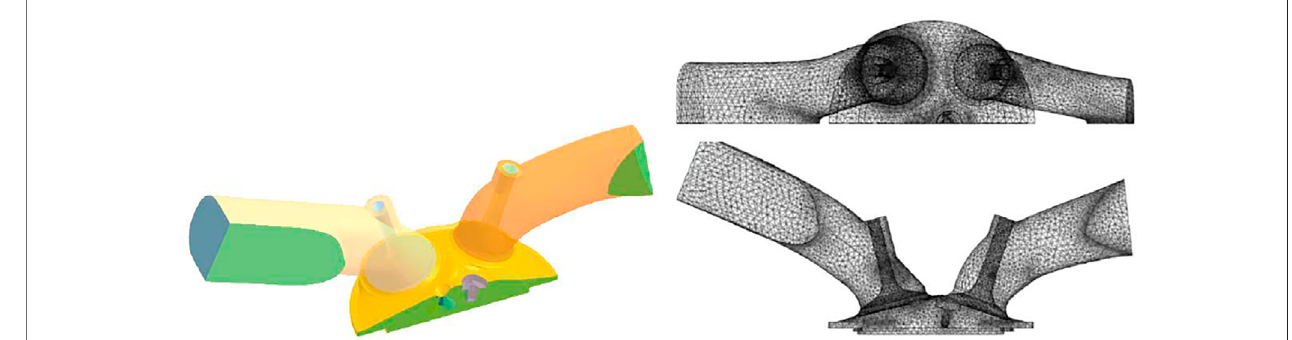
FIGURE 1 | Engine model geometry and mesh.